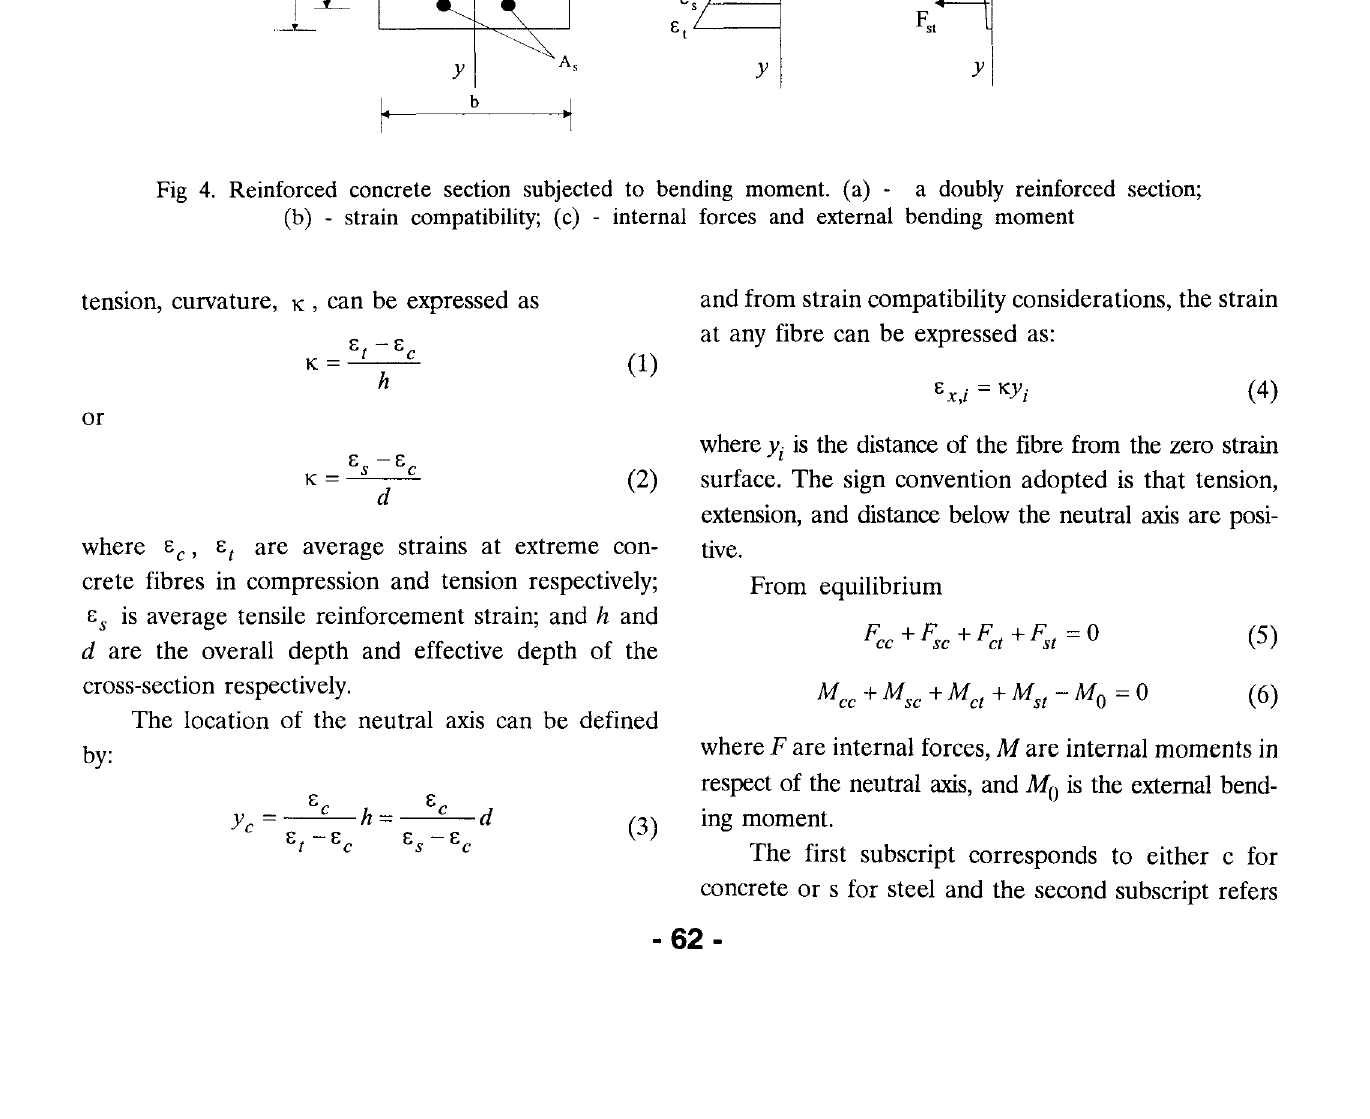
Fig 4. Reinforced concrete section subjected to bending moment (a) - a doubly reinforced section; (b) - strain compatibility; (c) - internal forces and external bending moment